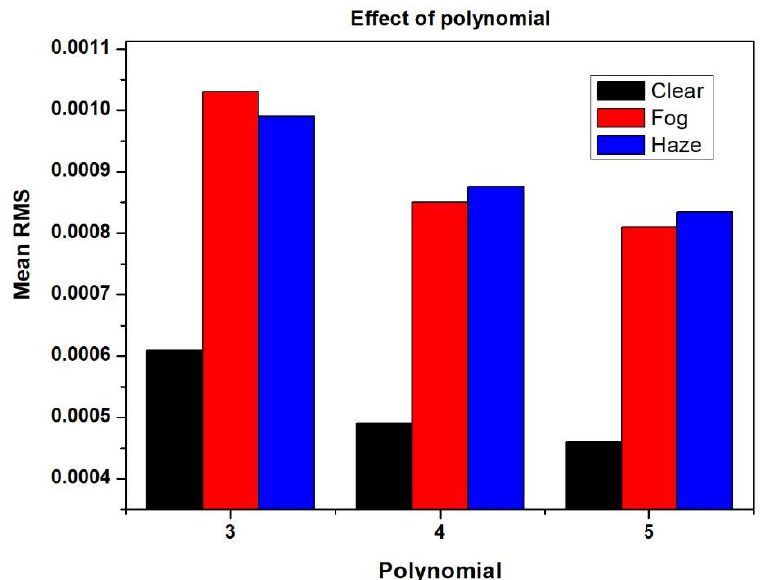
Figure 5. Effect of polynomial order on mean RMS of HCHO measured under different meteorological conditions.